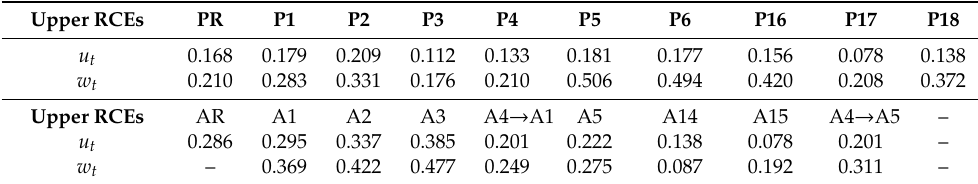
Table 4. The risk and weight of the upper RCEs of the coupling model V3: